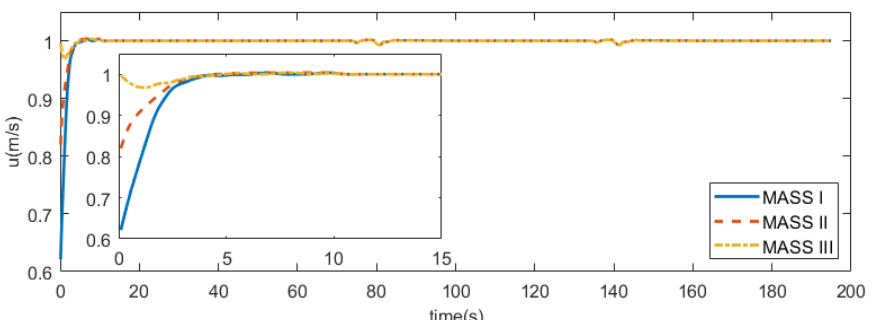
Figure 7. Reference path and path of MASSs.